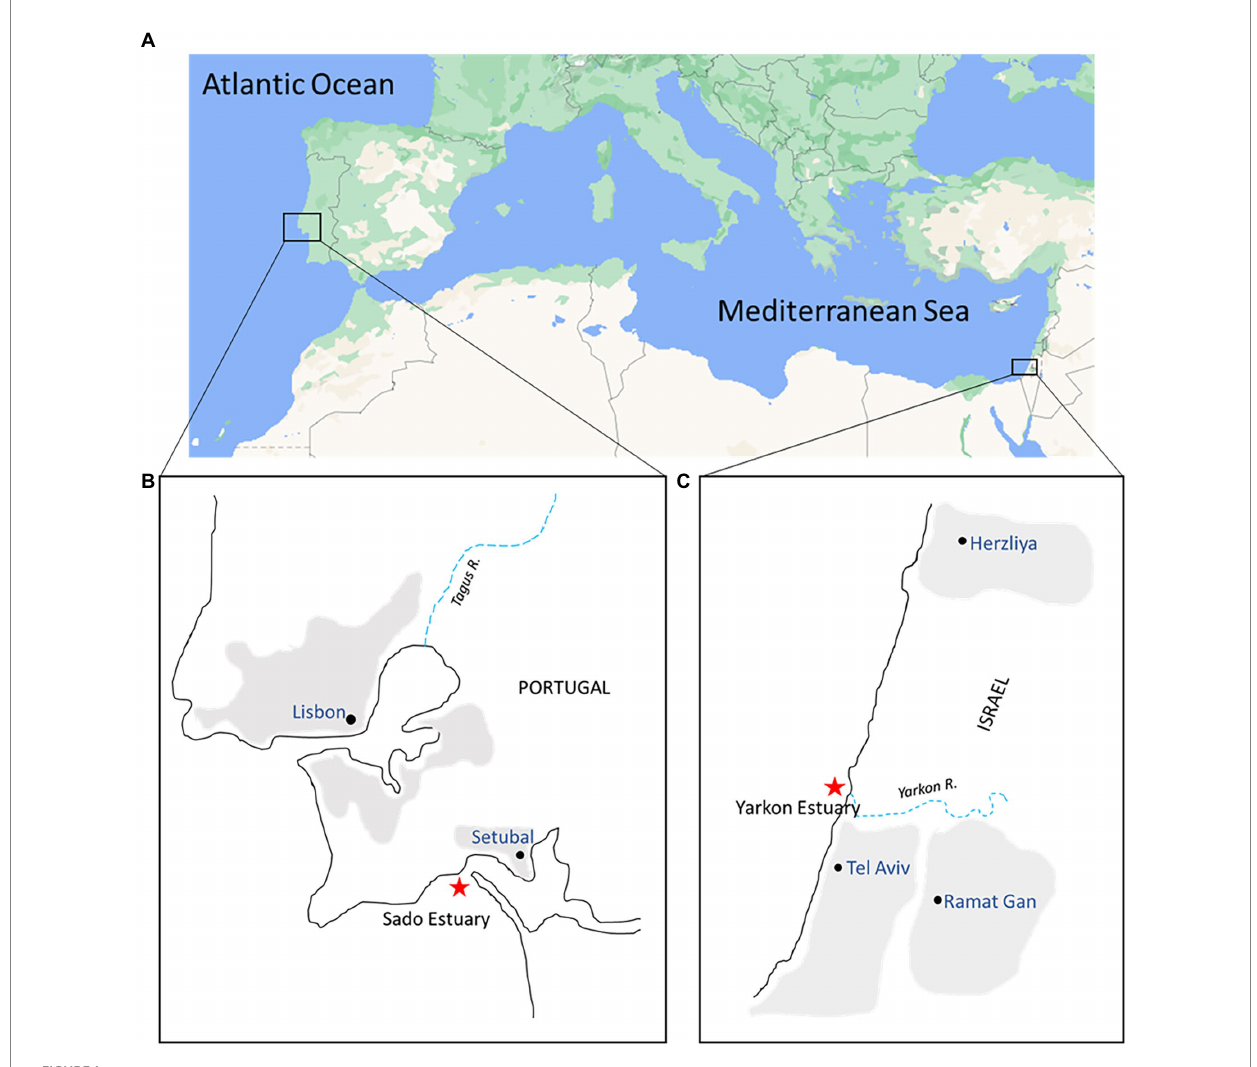
FIGURE 1 Map of collection sites. (A) Sampling areas in the eastern Atlantic Ocean (Portugal) and the eastern Mediterranean Sea (Israel); (B,C) Enlargement of the insets from (A) . Red stars indicate the Portugal and Israel sampling sites near the mouth of both estuaries.